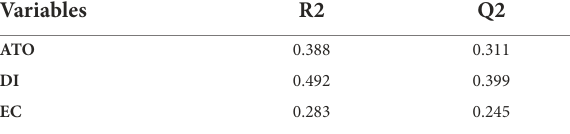
TABLE 7 R2 and Q2.